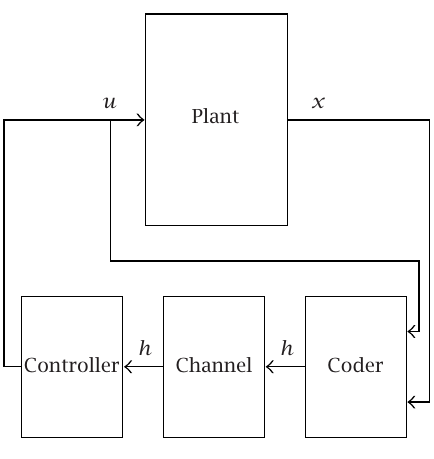
Figure 2.1. Coder-controller